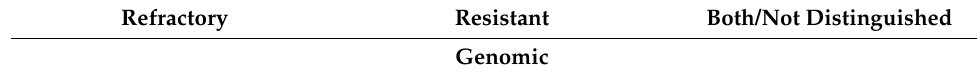
Table 2. Chemorefractory secretome vs. chemoresistant secretome. The table summarizes and illustrates the unique and overlapping factors between the chemorefractory and chemoresistant secretomes; these factors include cytokines, growth factors, genes, and proteins that amplify translational and transcriptional modifications. Many of these components directly contribute to HGSOC